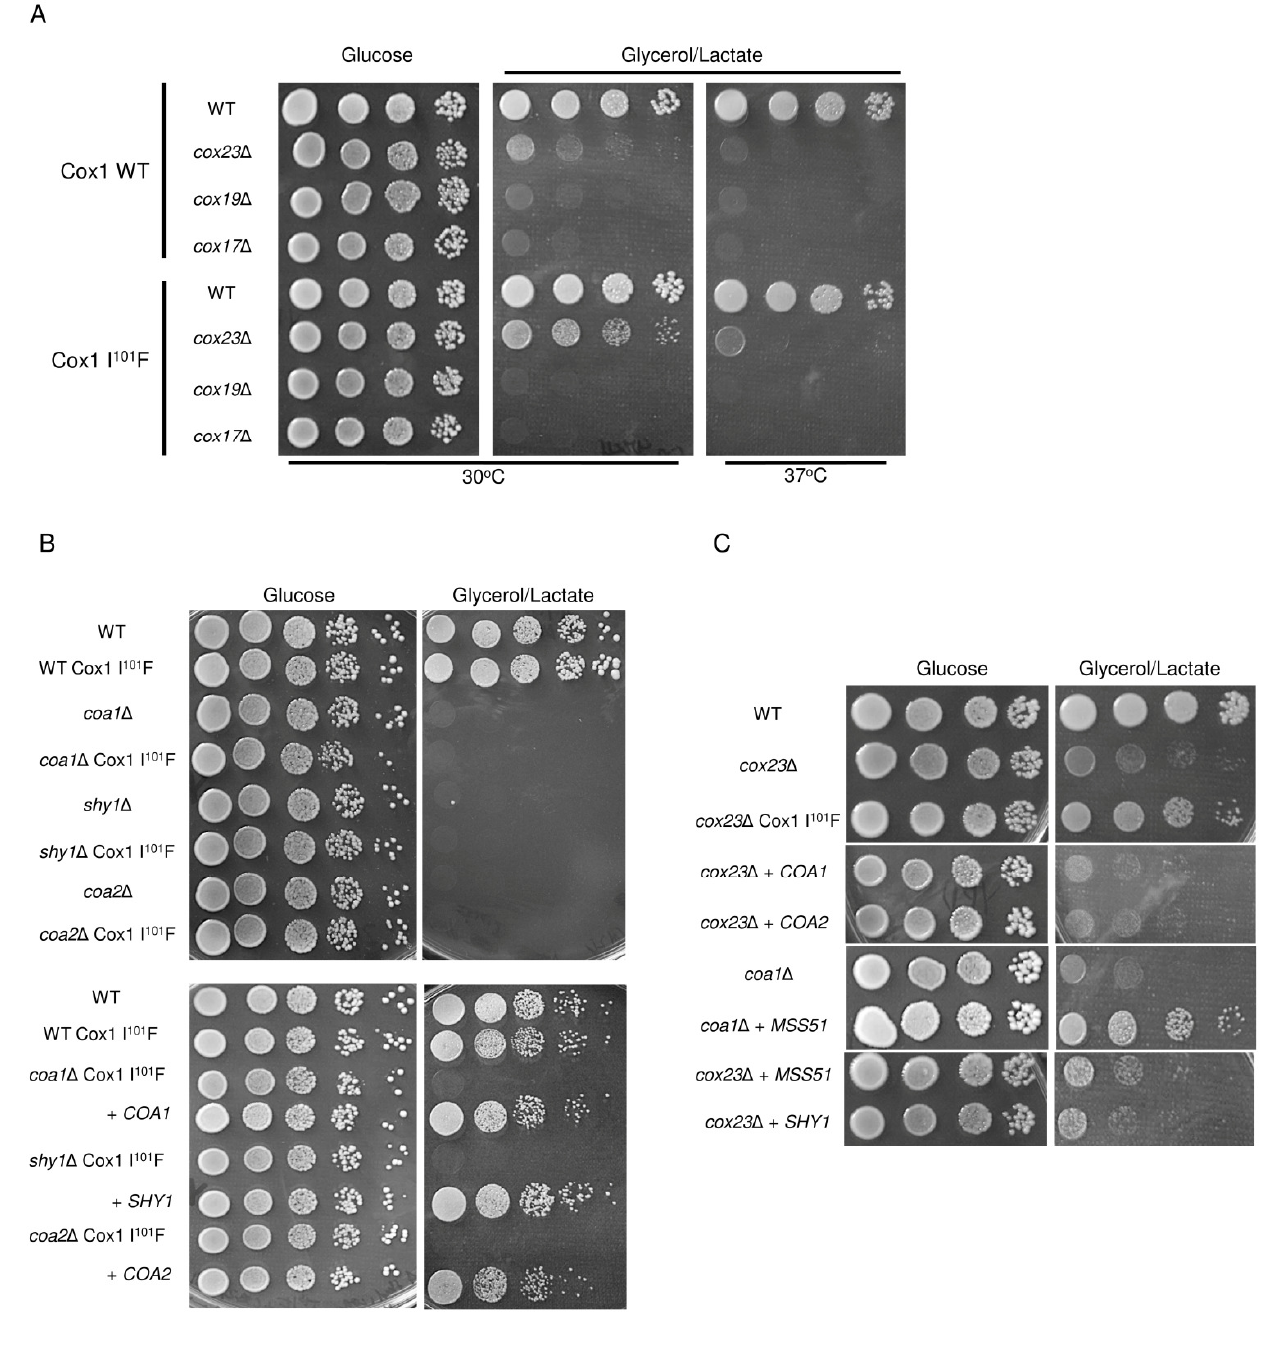
FIGURE 5: Suppression by Cox1 I 101 F is restricted to cox23 Δ cells. (A) cox17 Δ or cox19 Δ was introduced to BY haploid wild-type nuclear DNA with or without Cox1 I 101 F mtDNA mutation and plated on YPD and YPGL plates for 3 and 7 days at 30°C respectively. (B) coa1 Δ, c oa2 Δ or shy1 Δ was introduced to BY haploid wild-type nuclear DNA with Cox1 I 101 F mtDNA mutation and plated on YPD and YPGL plates and incubated at 30°C for 3 and 7 days respectively. (C) cox23 Δ cells were transformed with MSS51 , SHY1 , COA1 or COA2 overexpression plasmids and plated on YPD and YPGL plates and incubated for 3 and 7 days at 30°C